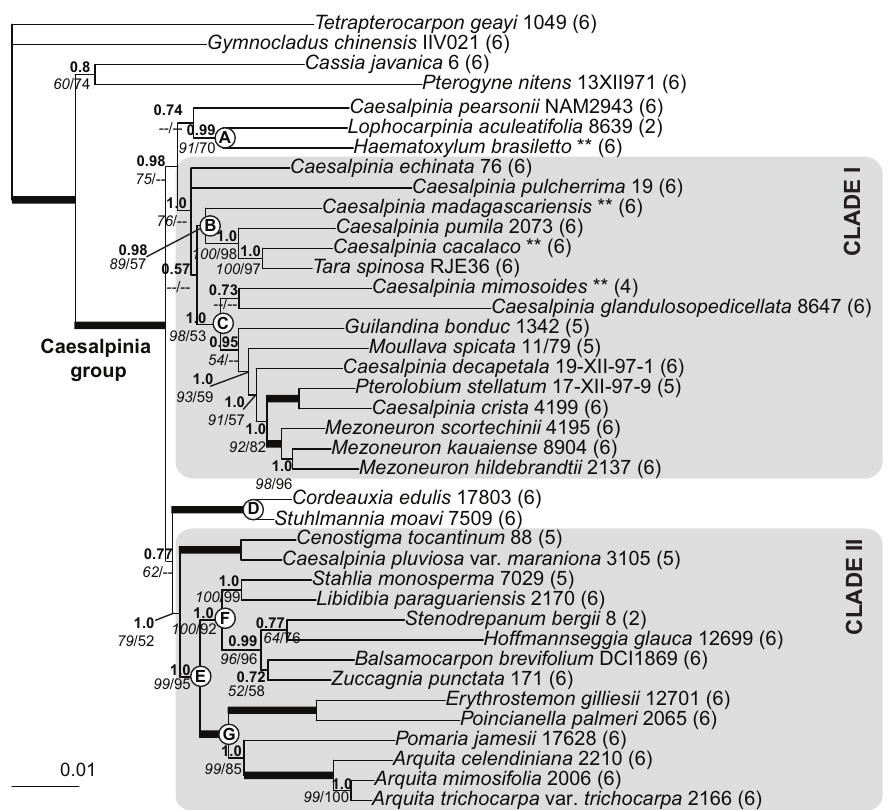
Figure 2. Phylogeny of the Caesalpinia group. Bayesian phylogram based on 39 accessions, minimizing missing data while maximizing the taxonomic representation of each of the 27 putative genera within the Caesalpinia group. Branch support values are indicated as follows: branches in bold indicate that maximum support has been attained in the parsimony, Maximum Likelihood and Bayesian analyses; otherwise, posterior probabilities are indicated above in bold, with bootstrap support from ML analyses (italicised) and parsimony analyses separated by a slash below the